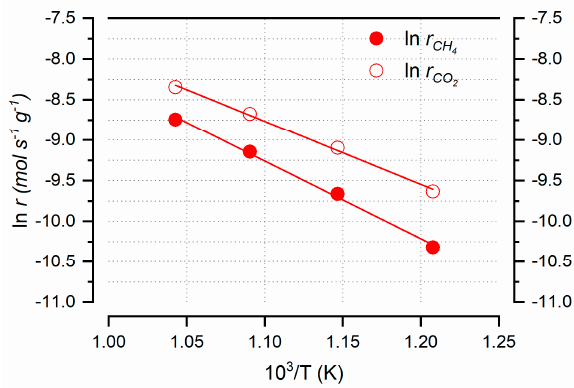
Figure 8. Arrhenius plots of CH 4 (closed symbol) and CO 2 (open symbol) consumption rate in F1.